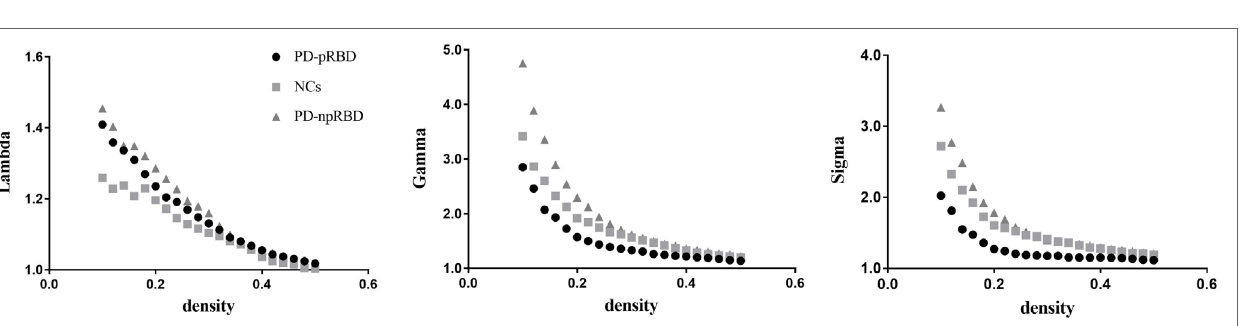
FigUre 2 | Small-worldness of normal controls (NCs), Parkinson’s disease (PD) patients with possible rapid eye movement sleep behavior disorder (RBD) (PD-pRBD), and PD patients with non-possible RBD (PD-npRBD). The graphs show the changes in Lambda, Gamma, and Sigma as a function of density thresholds. At a wide range of density, the network of each group have an average Gamma of greater than 1, an average Lambda of nearly 1, and Sigma greater than 1, which indicates prominent small-world properties.